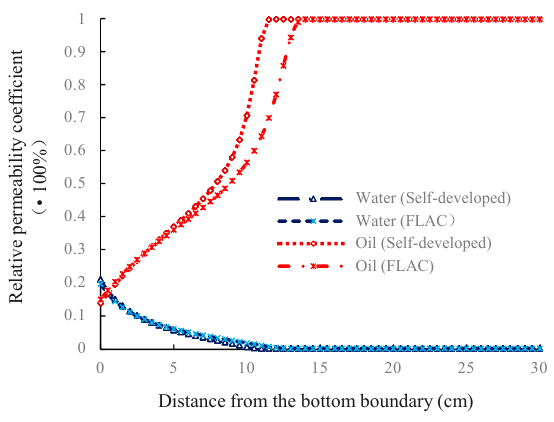
Figure 8. Simulated specific volumetric water content distribution after 5000 s.